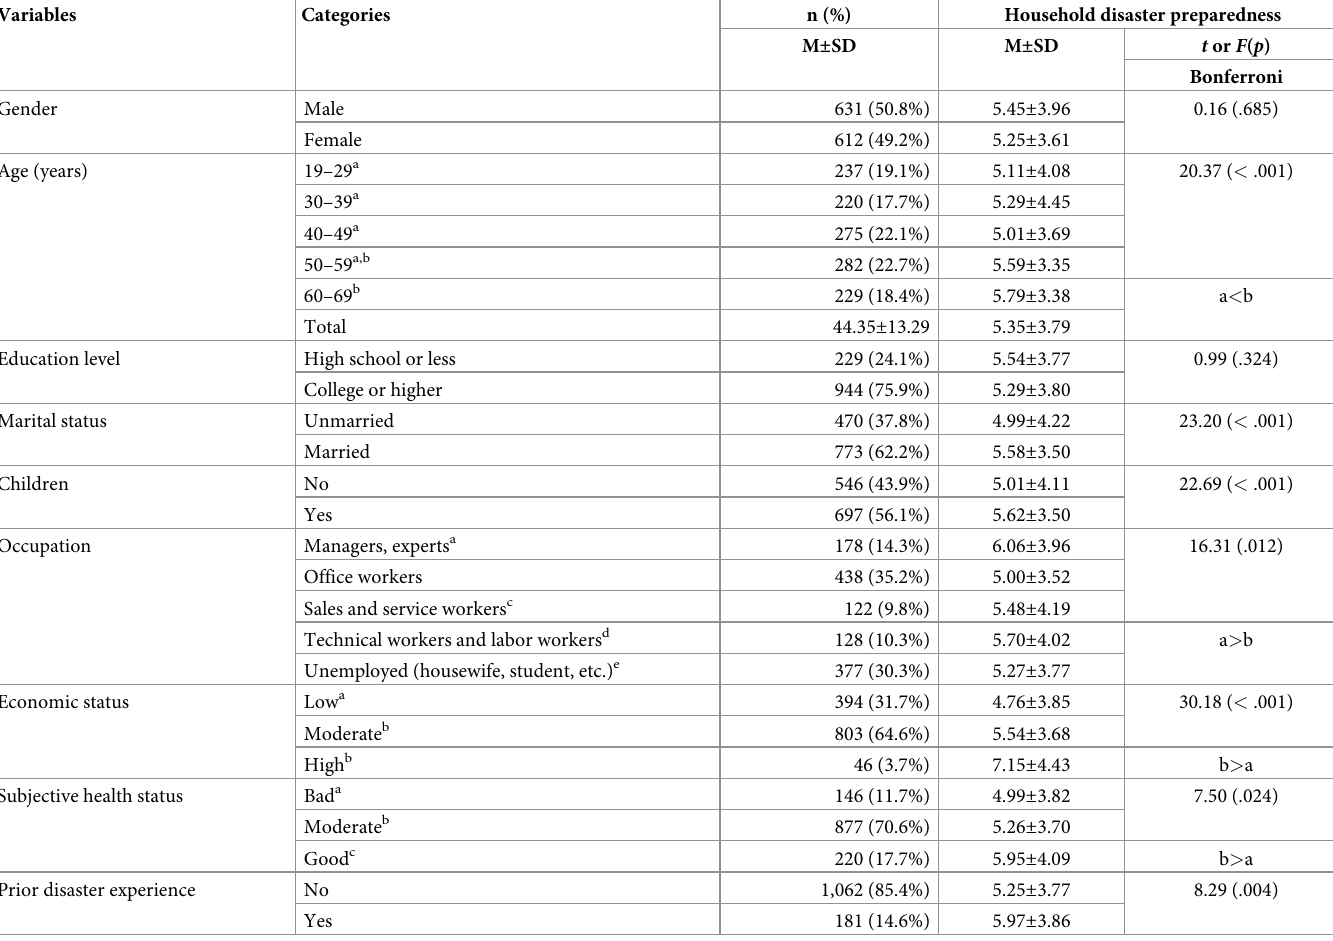
Table 1. Differences in household disaster preparedness according to the general characteristics of the participants ( N = 1,243).